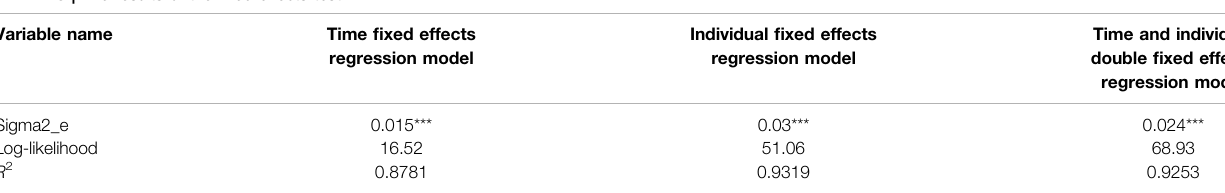
TABLE 8 | The results of the fi xed effects test.